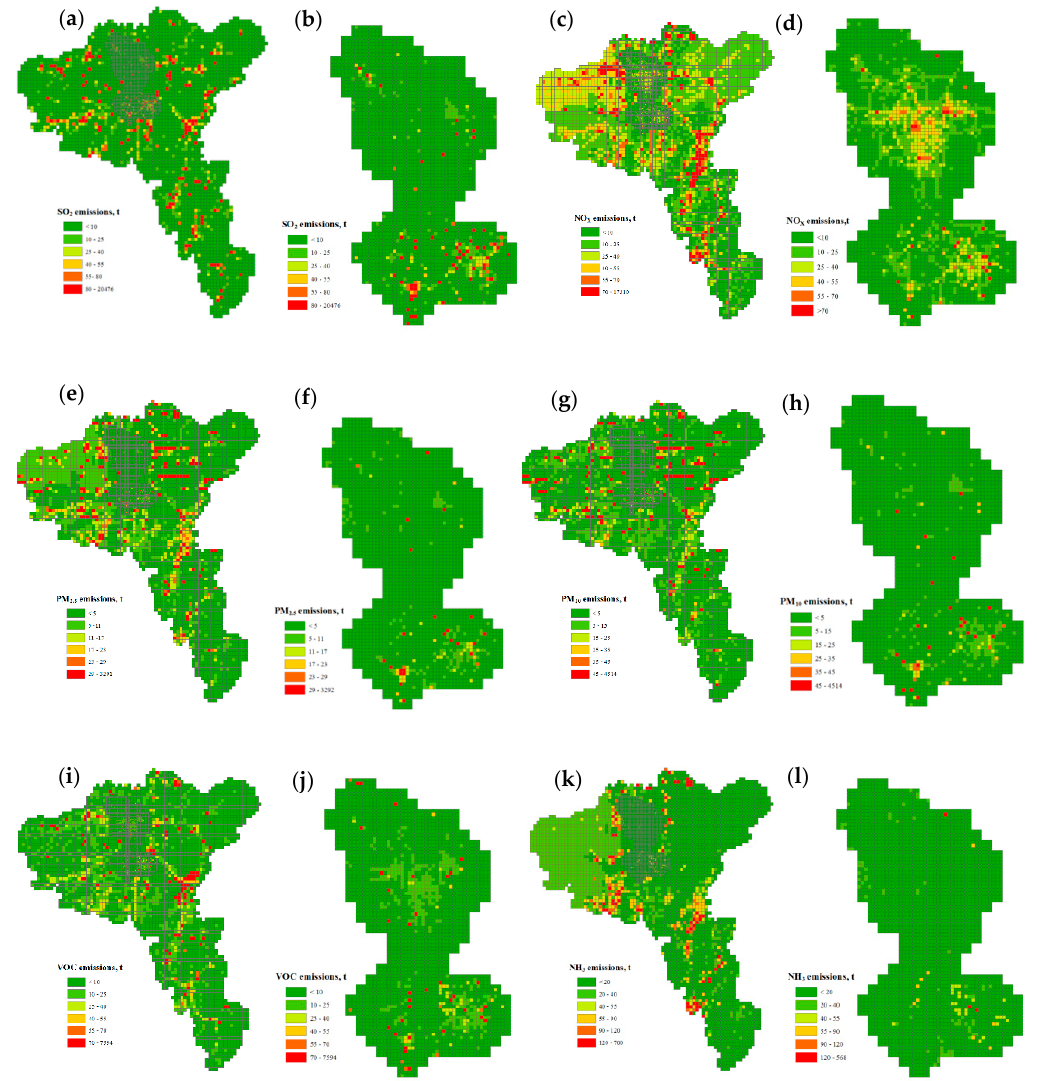
Figure 3. Spatial allocation of air pollutant emissions and annual concentrations in the Changzhutan (CZT) urban agglomeration in 2015. ( a ) sulfur dioxide (SO 2 ) emission (3 × 3 km). ( b ) SO 2 emission (1 × 1 km). ( c ) nitrogen oxides (NO X ) emission (3 × 3 km). ( d ) NO X emission (1 × 1km). ( e ) particulate matter 2.5 (PM 2.5 ) emission (3 × 3 km). ( f ) PM 2.5 emission (1 × 1 km). ( g ) particulate matter 10 (PM 10 ) emission (3 × 3 km). ( h ) PM 10 emission (1 × 1 km). ( i ) volatile organic compounds (VOCs)